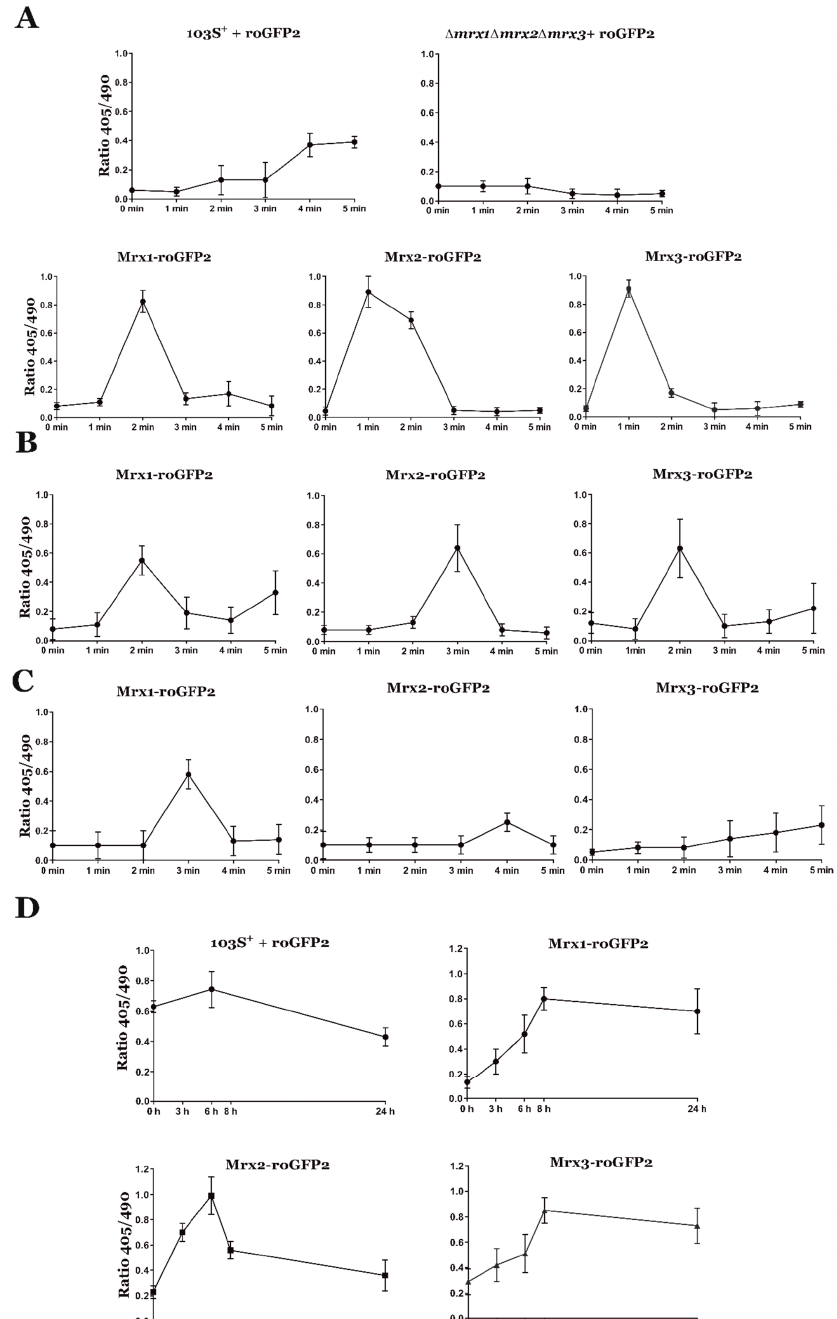
Figure 4. Fluorescence analysis of R. equi strains expressing the reduction-oxidation sensitive green fluorescent protein (roGFP2) biosensor under the control of the constitutive promoter P kan . All Mrxs-roGFP2 fusions were expressed in R. equi ∆ mrx1 ∆ mrx2 ∆ mrx3 . The 405 / 490 ratio fluorescence of ≈ 200 cells was evaluated at di ff erent time points during treatments with 5 mM H 2 O 2 ( A ), 5 mM NaClO ( B ), or 5 mM DETA NONOate ( C ), and during macrophage infection ( D ); fluorescence 405 / 490 ratio was calculated by confocal microscopy at di ff erent time points. Data are expressed as means ± SD of ≈ 200 cells from three independent